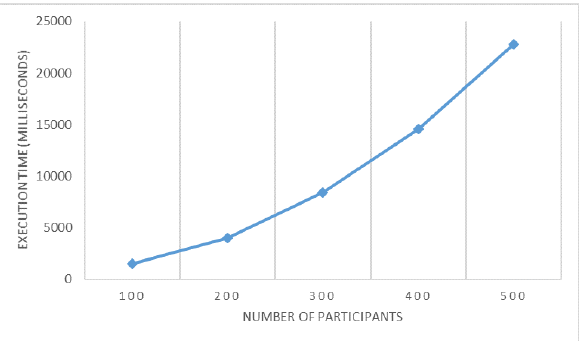
Figure 6. Graph showing a mean time comparison of number of participants and mean execution